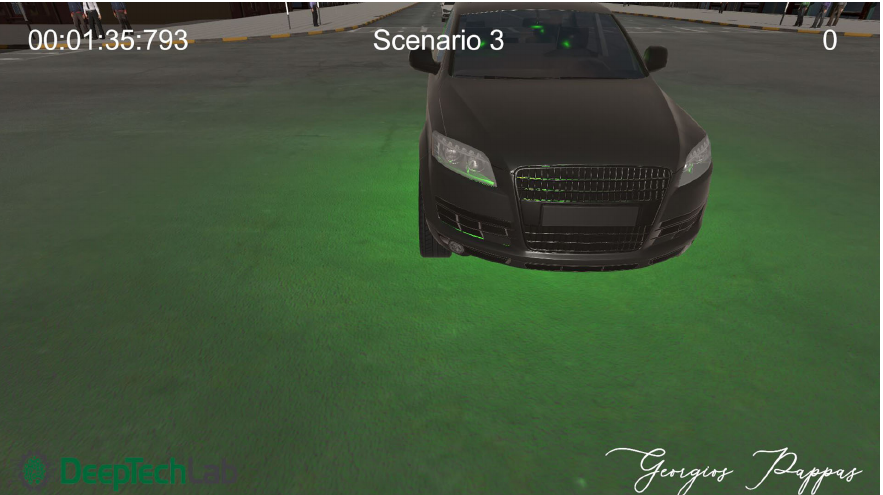
Figure 12. In scenario 3, the AVs are identified by a green light underneath. The light appears when the pedestrian is 15 m or less away from the